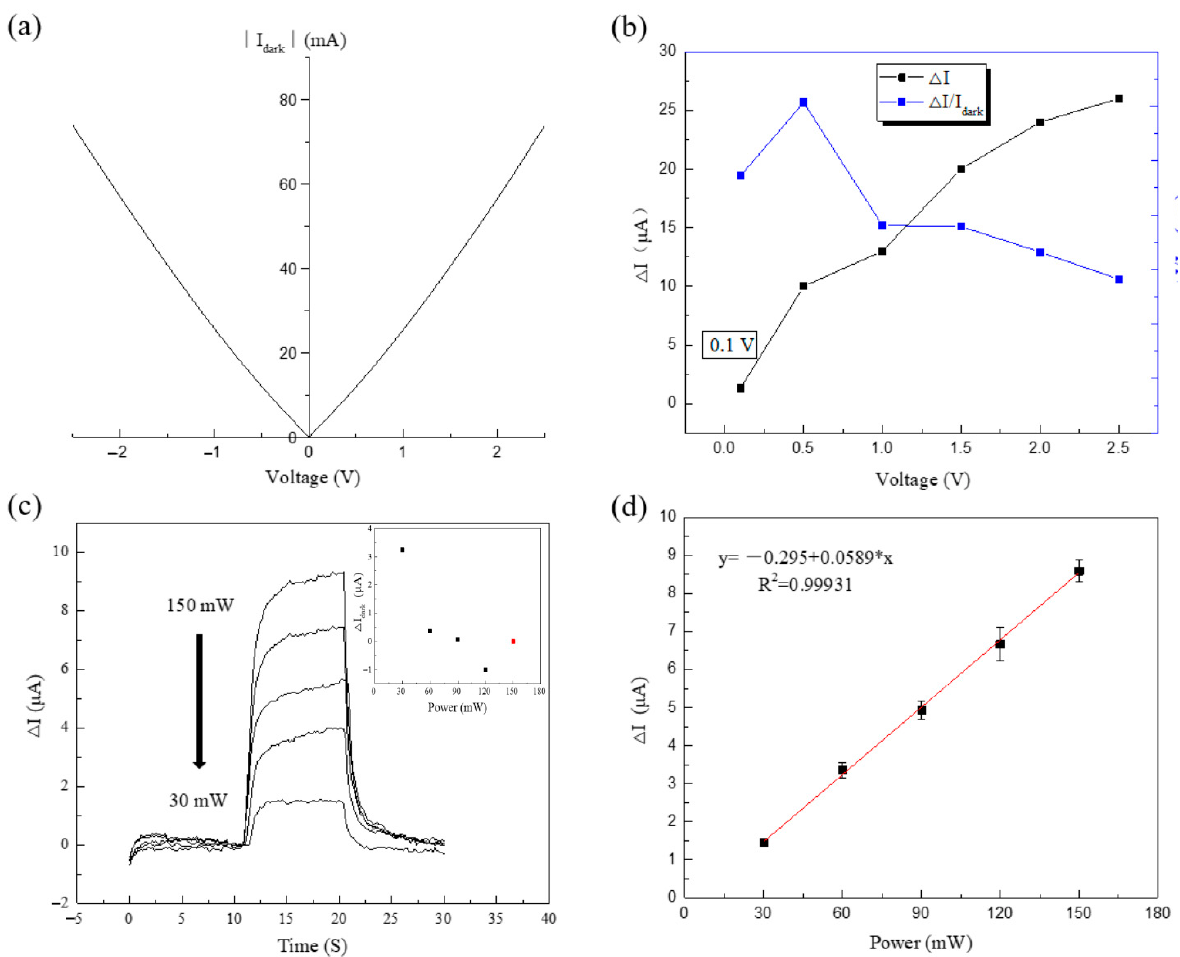
Figure 5. ( a ) The absolute value of dark current( | I dark | ) is measured at different bias voltage. ( b ) When the laser power is 150 mW, the light response of the device at different biases is measured (black line), and the ratio of the photocurrent to the dark current is get (blue line). ( c ) I-T curves of the light response of the device when the light is on and off at different laser powers. The inset shows the difference of the initial dark current at different powers, with the initial dark current at 150mW (red dot) as the reference point. ( d ) At 15 s, the photocurrent of the device at different laser powers.The red line is the fitting line of the photocurrent of the device with the change of laser power. The black dots represent the average of the results, and the short lines represent the standard deviation.